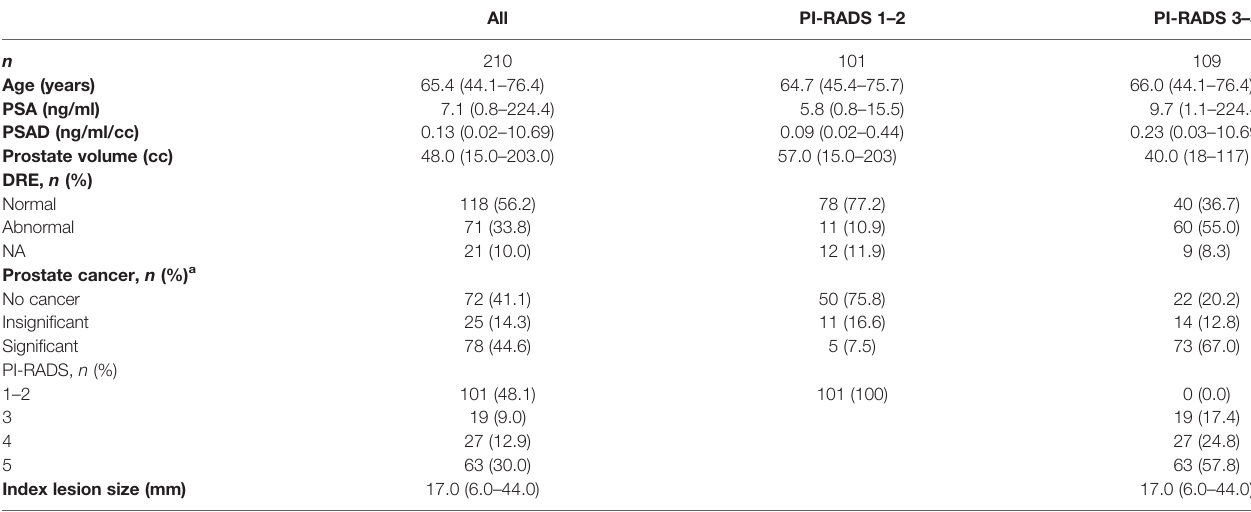
TABLE 1 | Clinical characteristics of the study population.